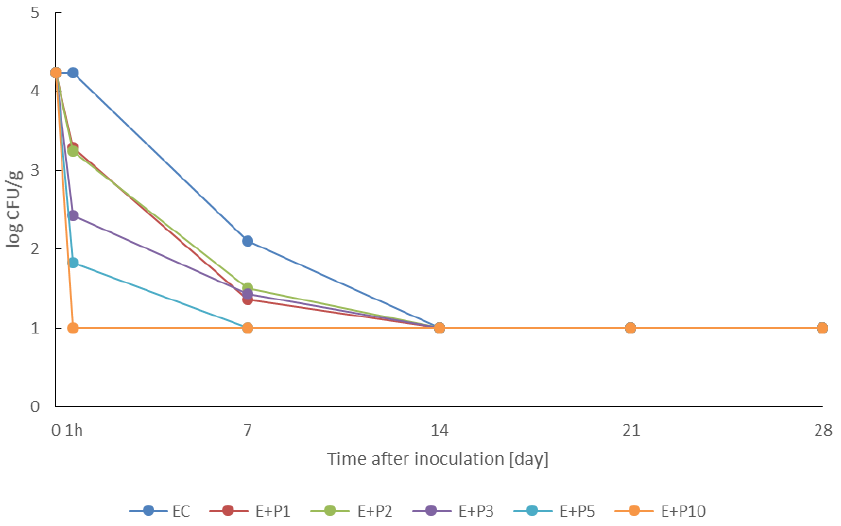
Figure 1. Changes in the number of F. solani on hen eggshells during 28 days after inoculation. Treatments: EC—control hen eggs, E + P1–E + P10 coated hen eggs with 1–10% with ethanol propolis Treatments: EC — control hen eggs, E + P1 – E + P10 coated hen eggs with 1 – 10% with ethanol propolis extract at concentrations of extract at concentrations of 1 – 10%.